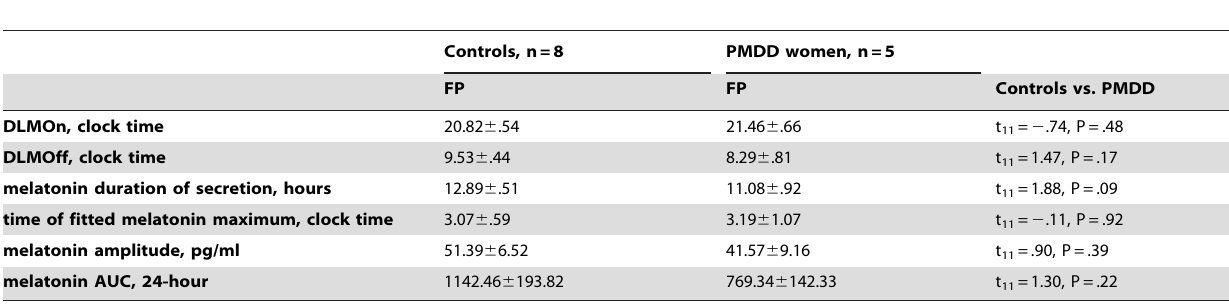
Table 4. Circadian melatonin profile during the follicular phase in PMDD women and an expanded group of controls. {